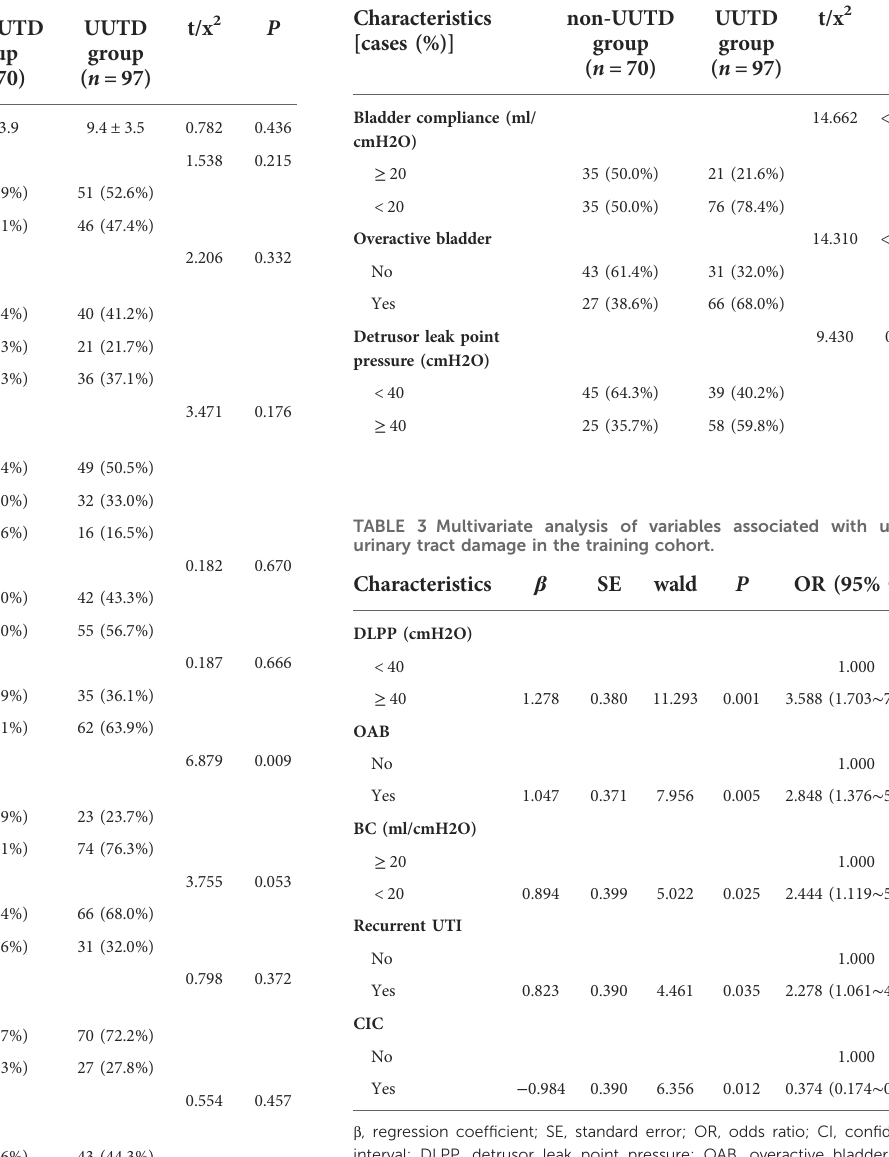
(13). The physician ’ s professional level varied depending on the hospital level and geographic region; thus, their individual judgments of patients ’ condition and prognosis were also different. A nomogram provides doctors with a standard calculation formula and reduces diagnostic errors caused by different levels of clinical experience. In addition, help patients in underdeveloped medical resources areas to receive more formal and convenient diagnosis and treatment. Some studies have even shown that nomograms seemed to substantially outperform clinical experts in some respects (14 – 16).